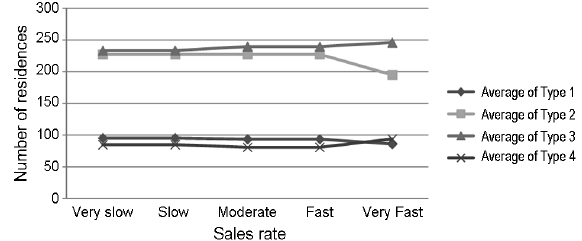
Fig. 5. Number of residences of the investment project depending on r